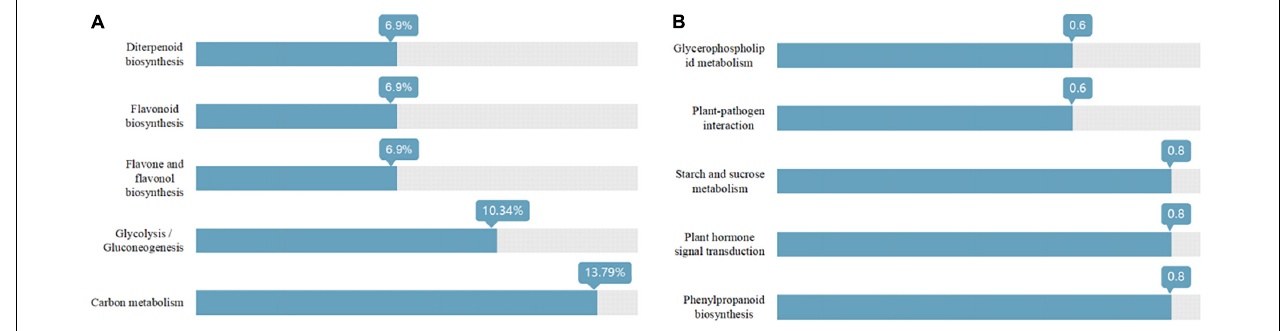
FIGURE 4 | KEGG annotation of the DEGs (only up-regulated) in control condition combined with B. cereus (CK+B) vs control (CK) (A) and salt stress combined with B. cereus (S+B) vs salt stress (S) (B) comparisons in G. uralensis (Selected the top five items).